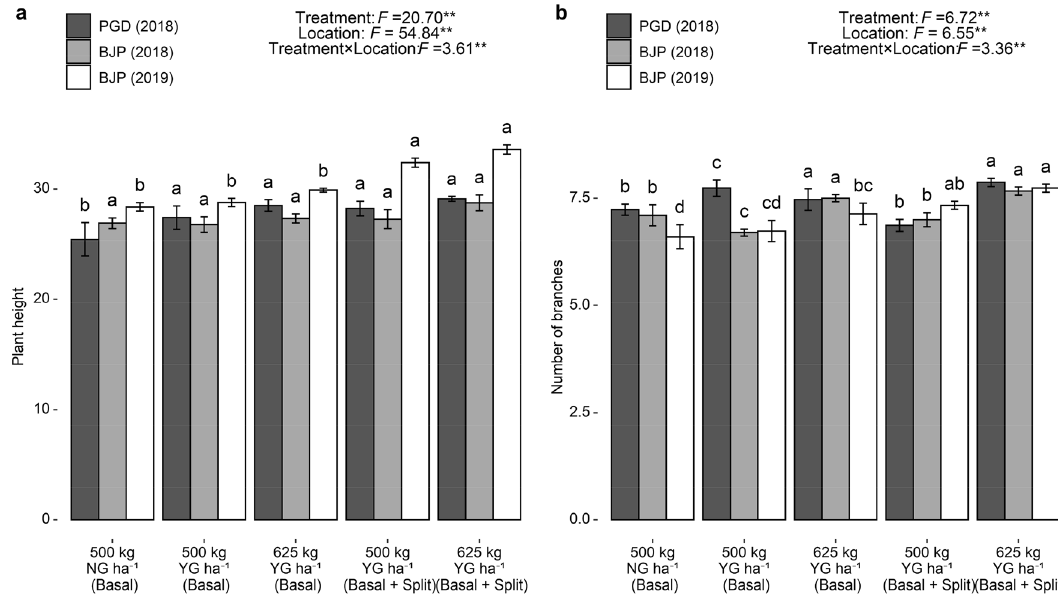
Figure 2. Effect of YG and NG on plant height ( a ) and number of branches ( b ) of groundnut. F value and significance level (** P < 0.01, * P < 0.05 and ns P ≥ 0.05). Values followed by a different letter within the same location are significantly different at P < 0.05 probability level. Capped bars at the surface of vertical bars represent the standard deviation, n = 3. YG yellow gypsum, NG natural gypsum, PGD Pavagada, BJP